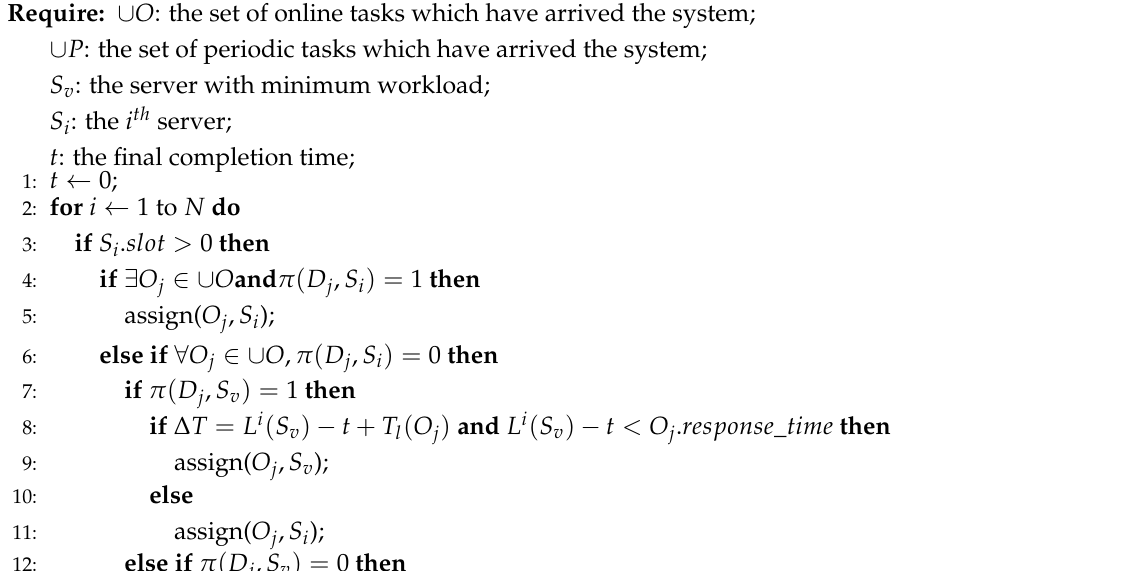
Algorithm 1 Heterogeneous task